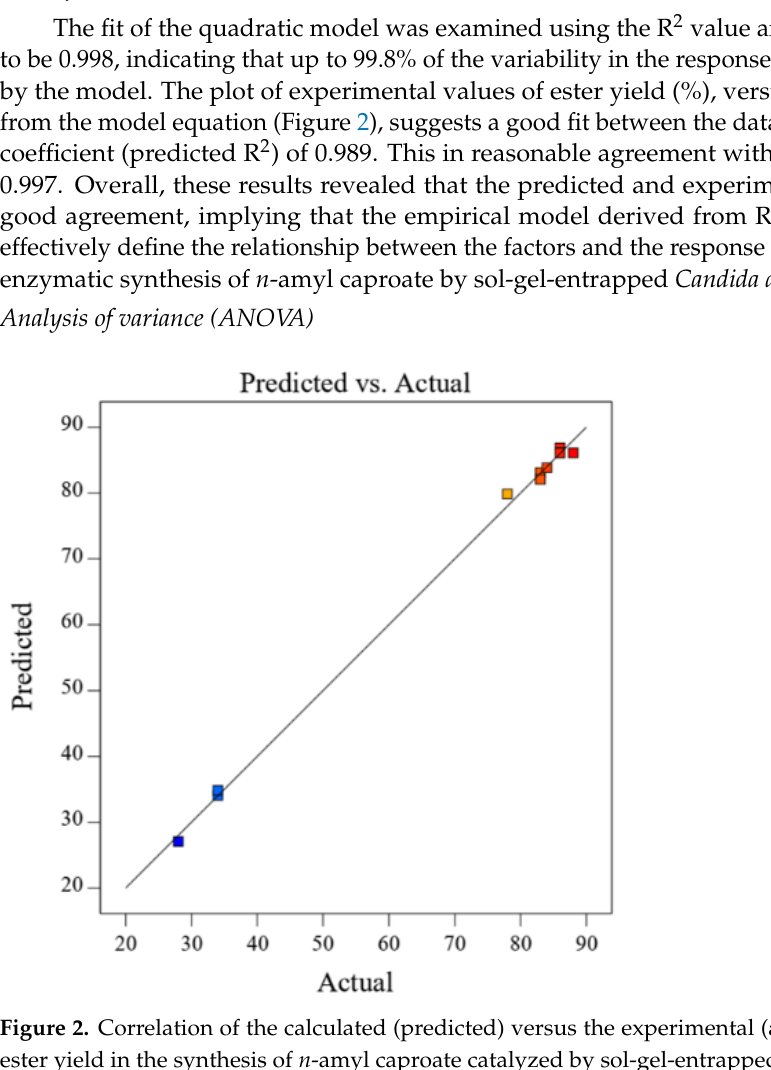
Figure 2. Correlation of the calculated (predicted) versus the experimental (actual) values for the ester yield in the synthesis of n -amyl caproate catalyzed by sol-gel-entrapped lipase from Candida antarctica B.